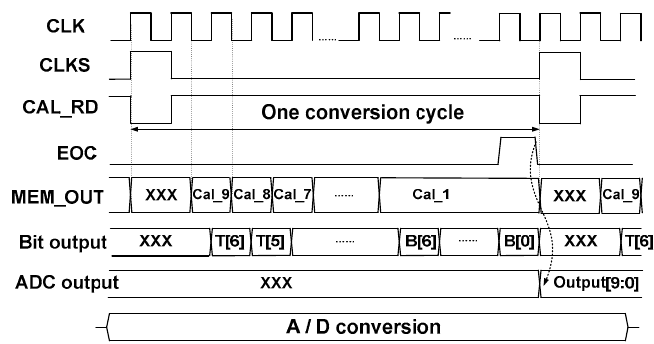
Figure 7. Timing waveform for comparator offset measurement. Figure 8. Timing waveform during normal A/D conversion when the offset calibration data are applied.